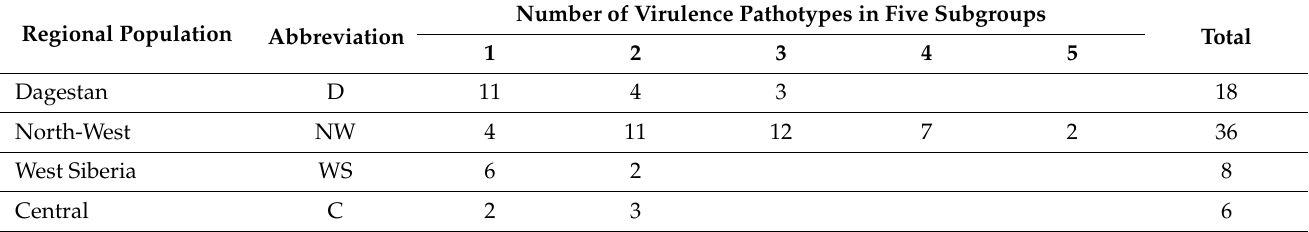
Table 6. Virulence pathotypes in subgroups within regional Puccinia striiformis populations.